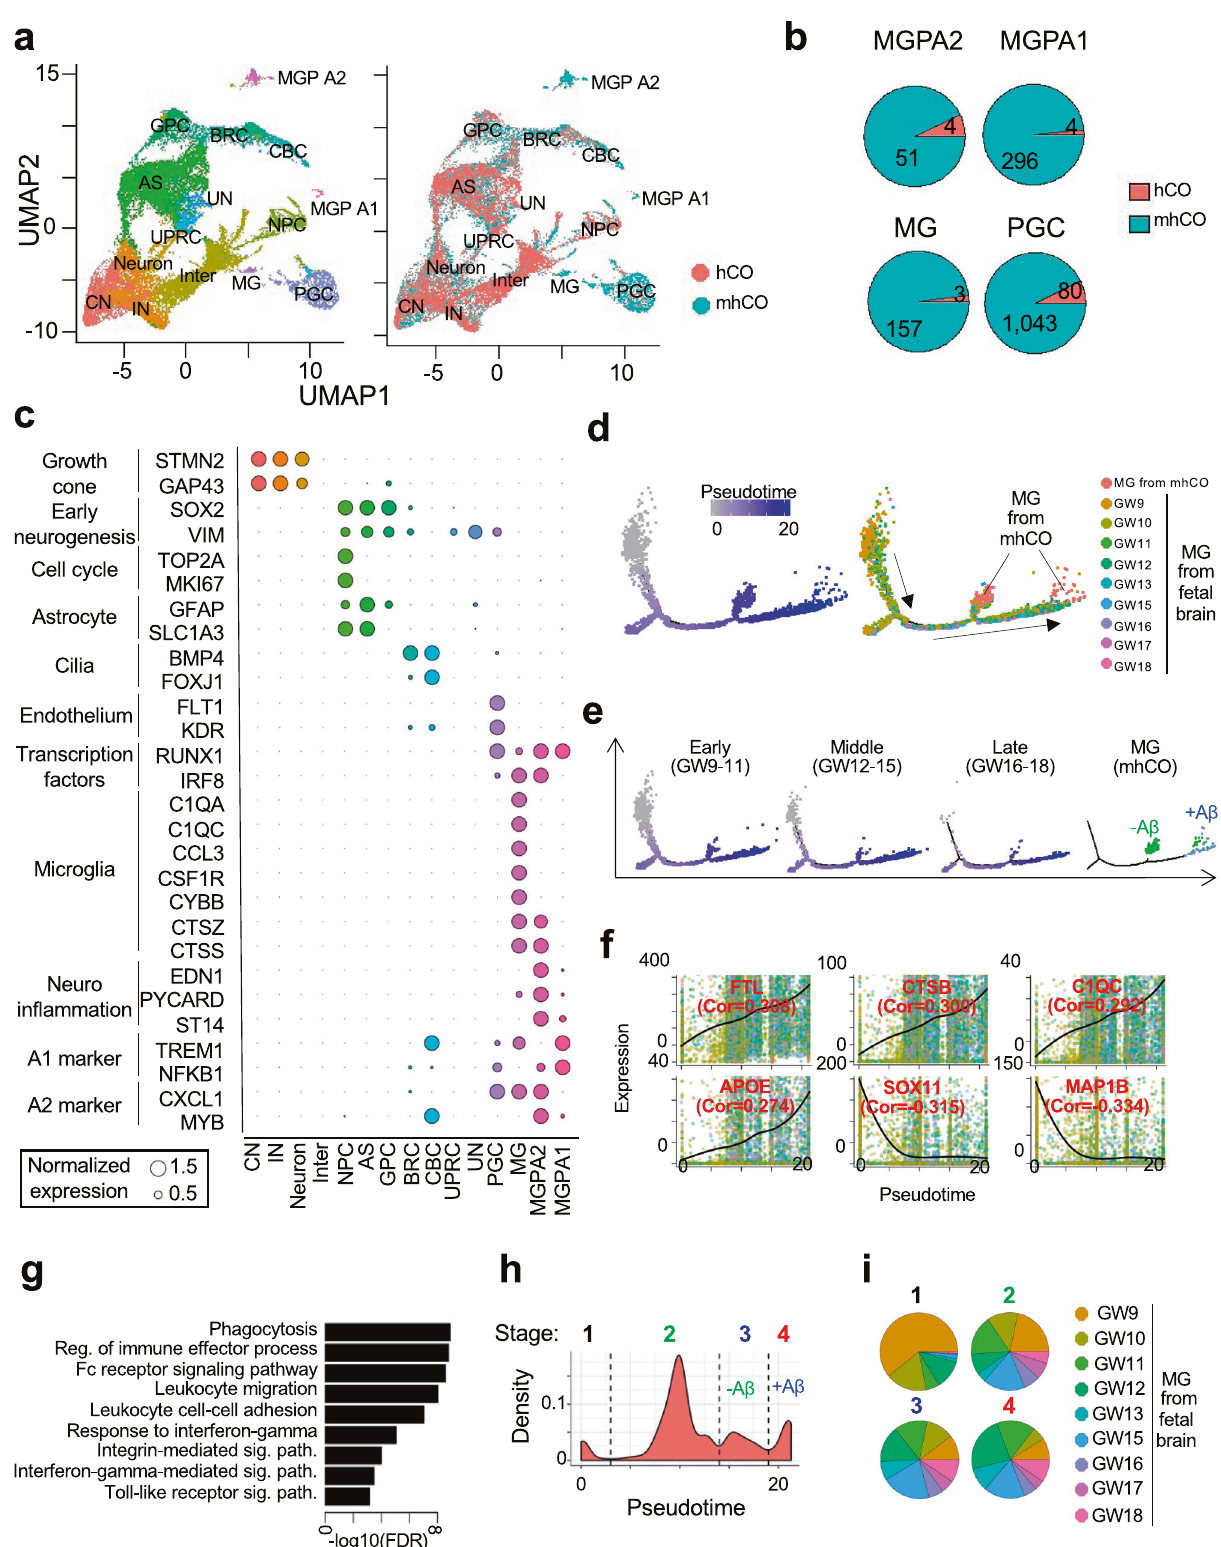
fetal brain to pathological